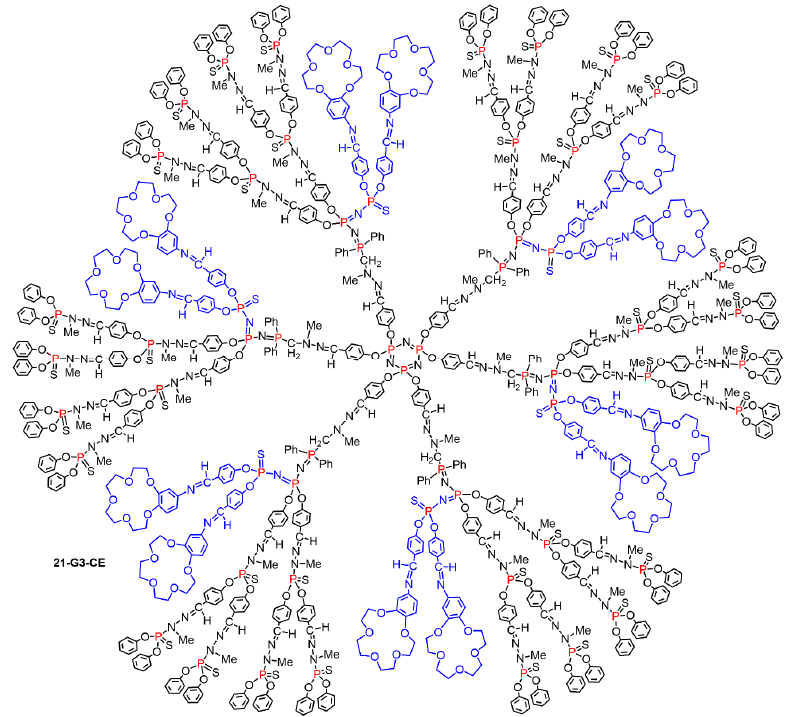
Figure 13. Full structure of the dendrimer 21-G3-CE bearing 12 crown ether derivatives inside its structure.